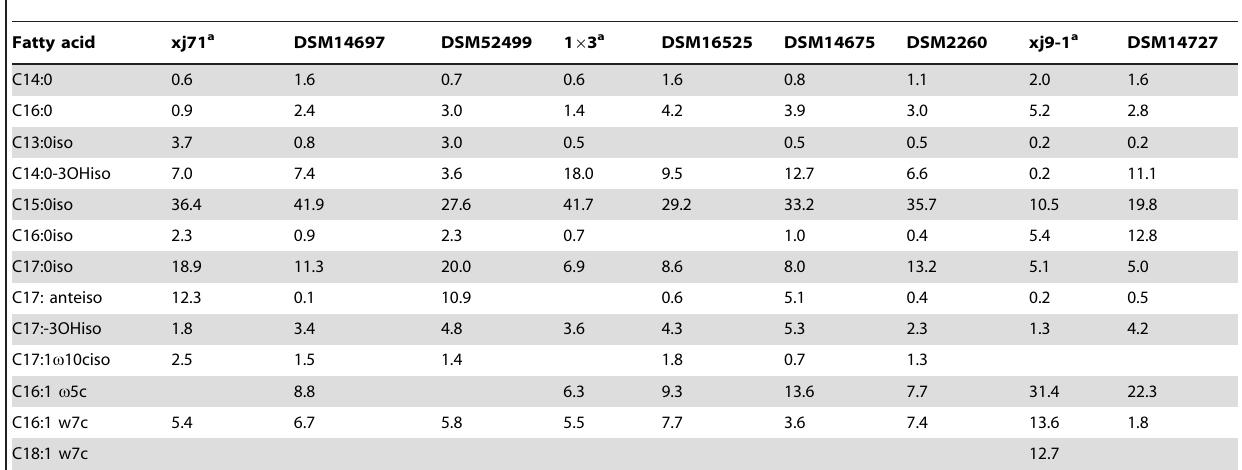
Table 6. Major fatty acids of new isolates and reference strains.